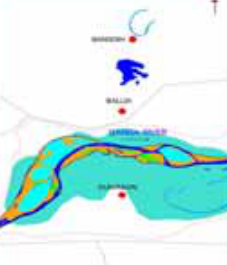
Fig 4 (f): Fluvial features as demarcated from 2006 pre-